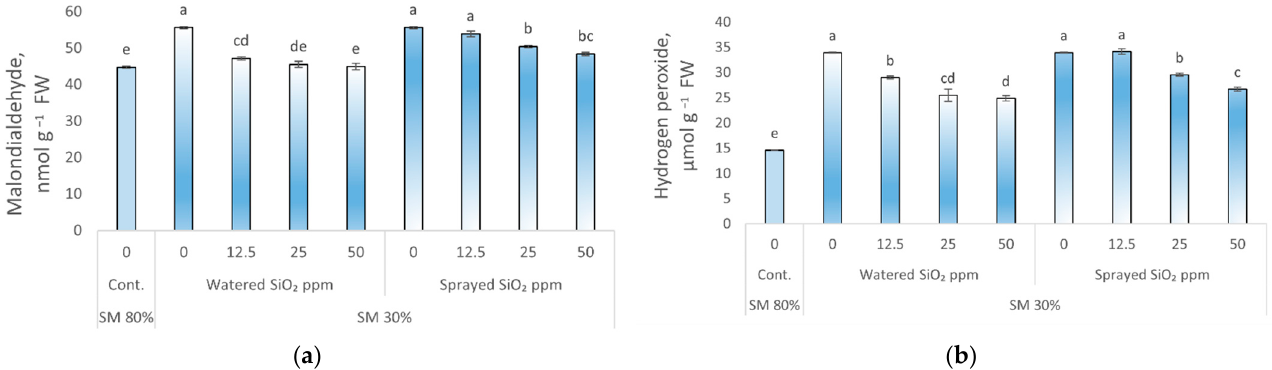
Figure 2. Influence of drought stress and SiO 2 NPs (0; 12.5; 25; and 50 ppm) on malondialdehyde content (MDA), ( a ); hydrogen peroxide (H 2 O 2 ), ( b ) in P. sativum L. Cont.—control plants, substrate moisture (SM) 80%; drought stress—SM 30%. Values are mean ± SE of three replicates and different letters are differed significantly by Tukey HSD Test ( p <